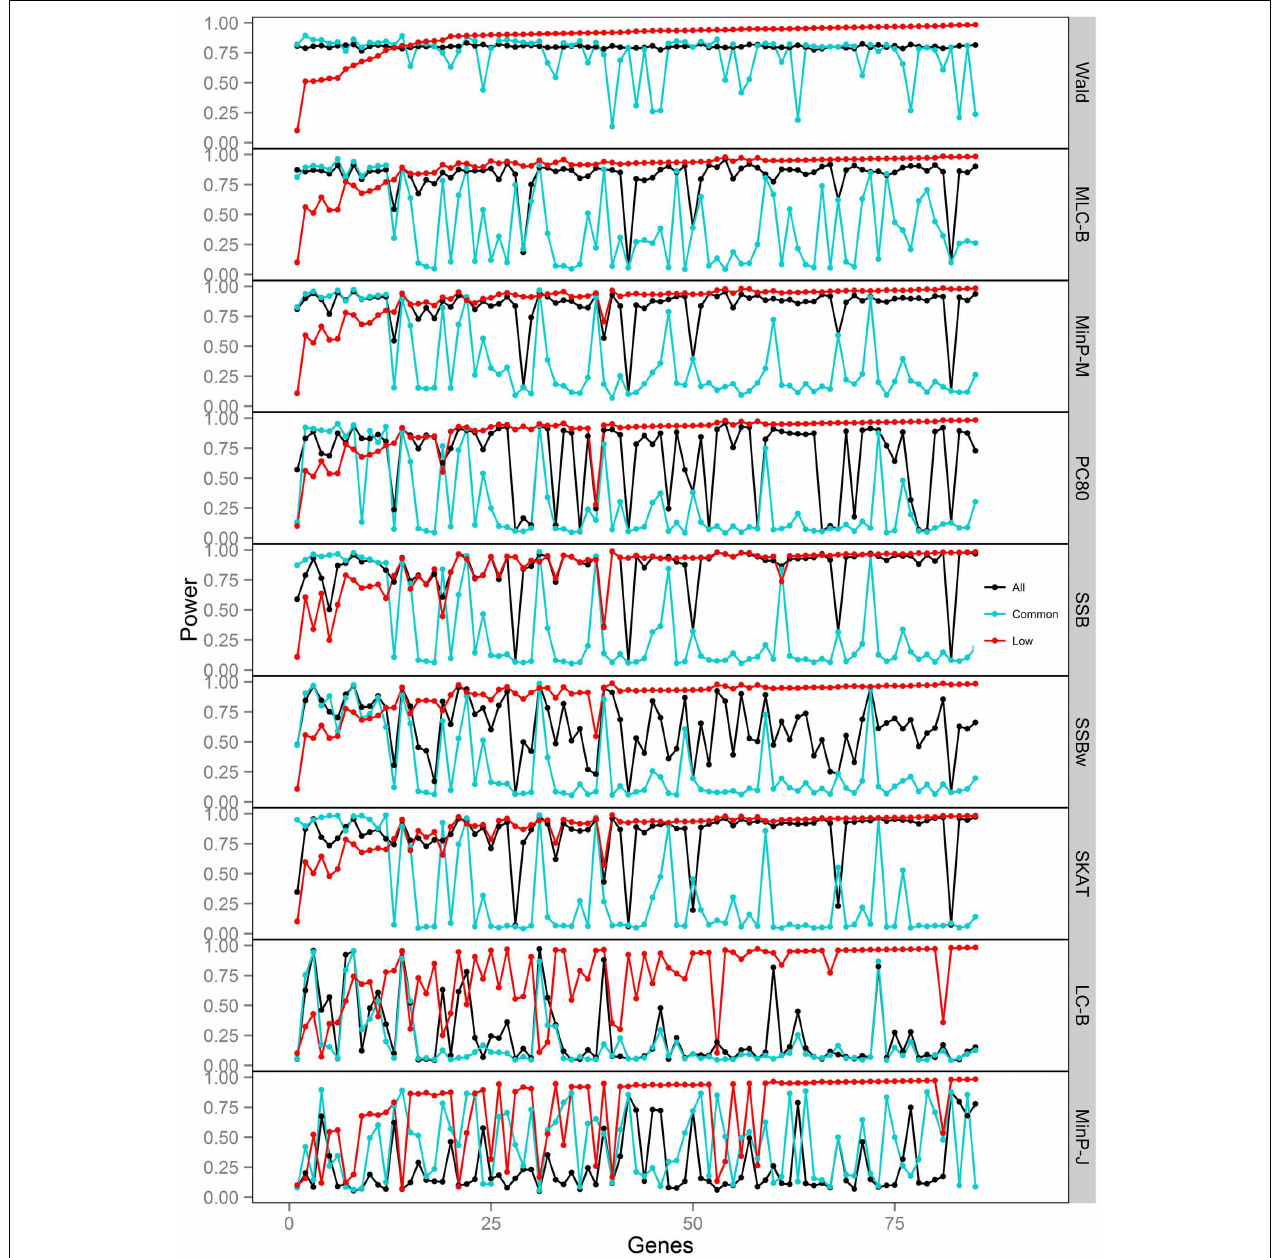
FIGURE 4 | Power of gene-based tests using three analysis sets of SNPs for 85 genes under trait Model 2. Genes are ordered along the horizontal axis according to the empirical power of Wald test using only low frequency SNPs.